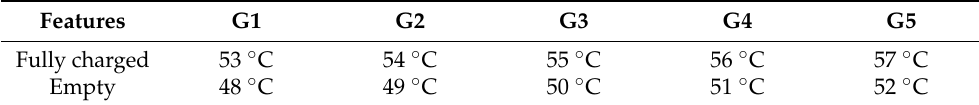
Table 3. Five definitions (G1 to G5) of the state of the heat storage as transition conditions.